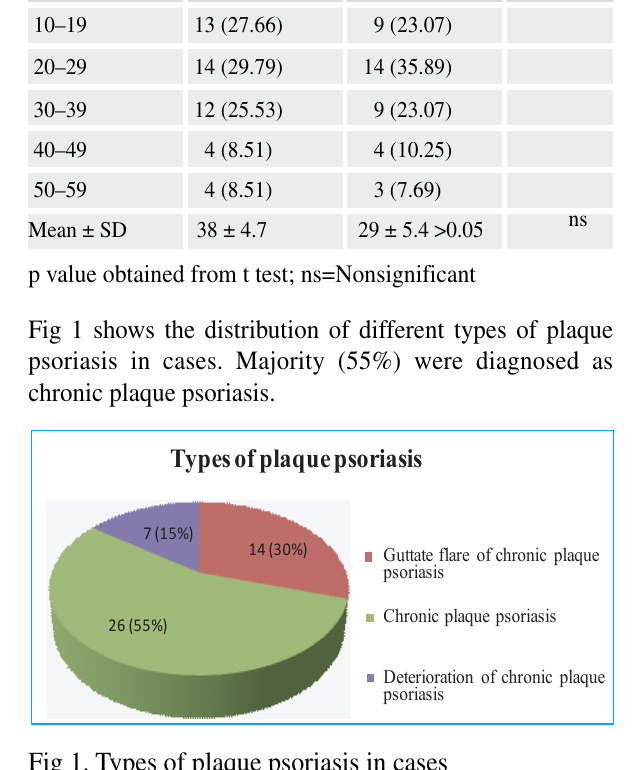
Fig 1. Types of plaque psoriasis in cases